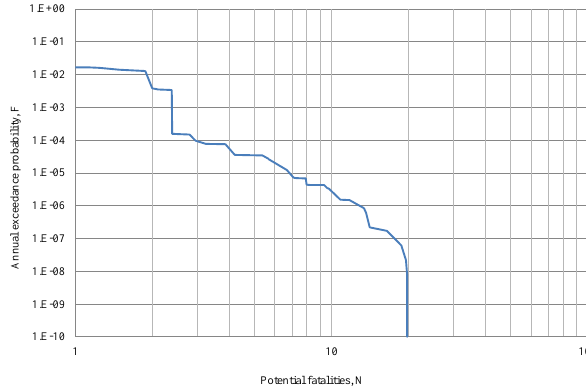
Fig. 9. FN-curve for the Base Case .